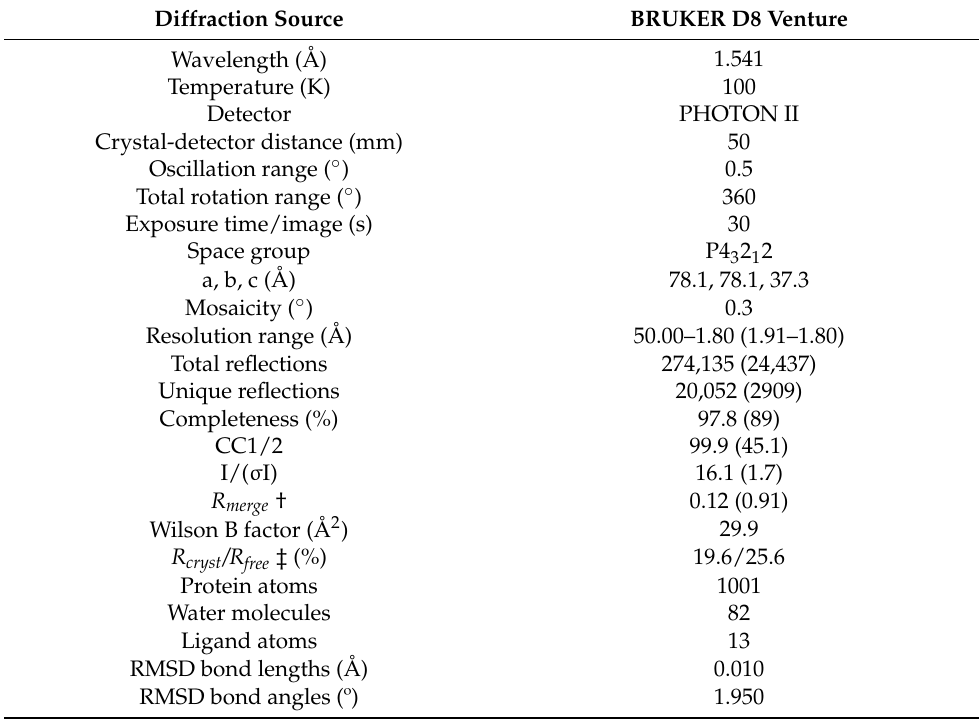
Table 1. Data collection and refinement